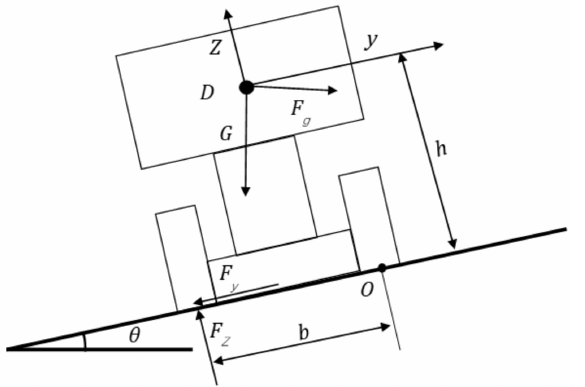
Figure 2. Vehicle mechanical analysis model after a collision with a superelevation circular curve